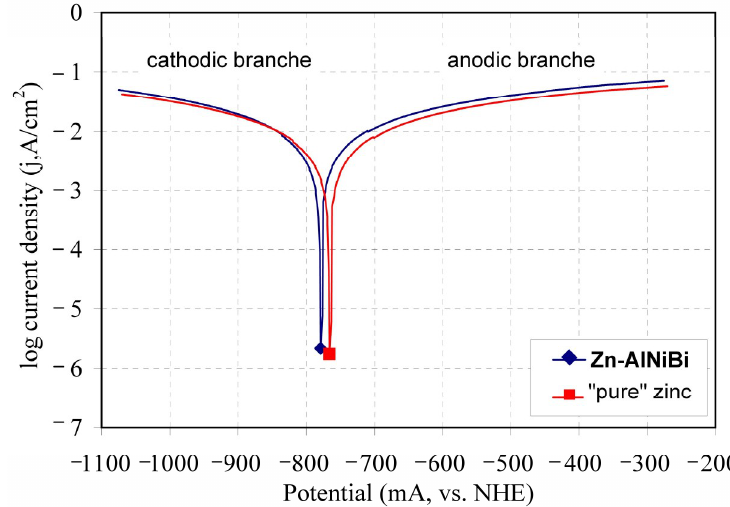
Figure 10. Polarization curves of coatings obtained in Zn-AlNiBi and “pure” zinc baths.